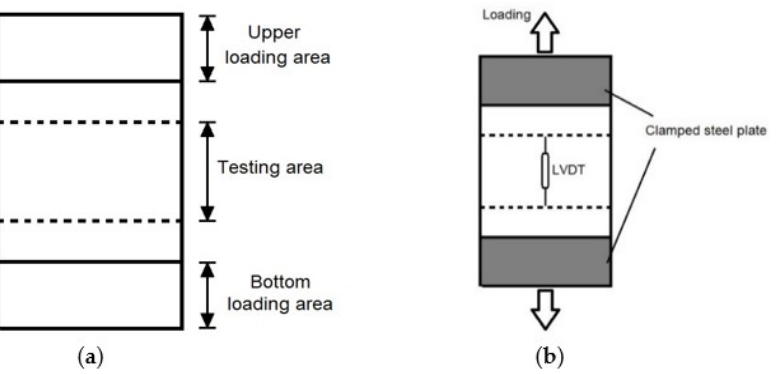
Figure 9. ( a ) Typical geometry and ( b ) test setup for tensile test of TRC specimen adopted from [68].